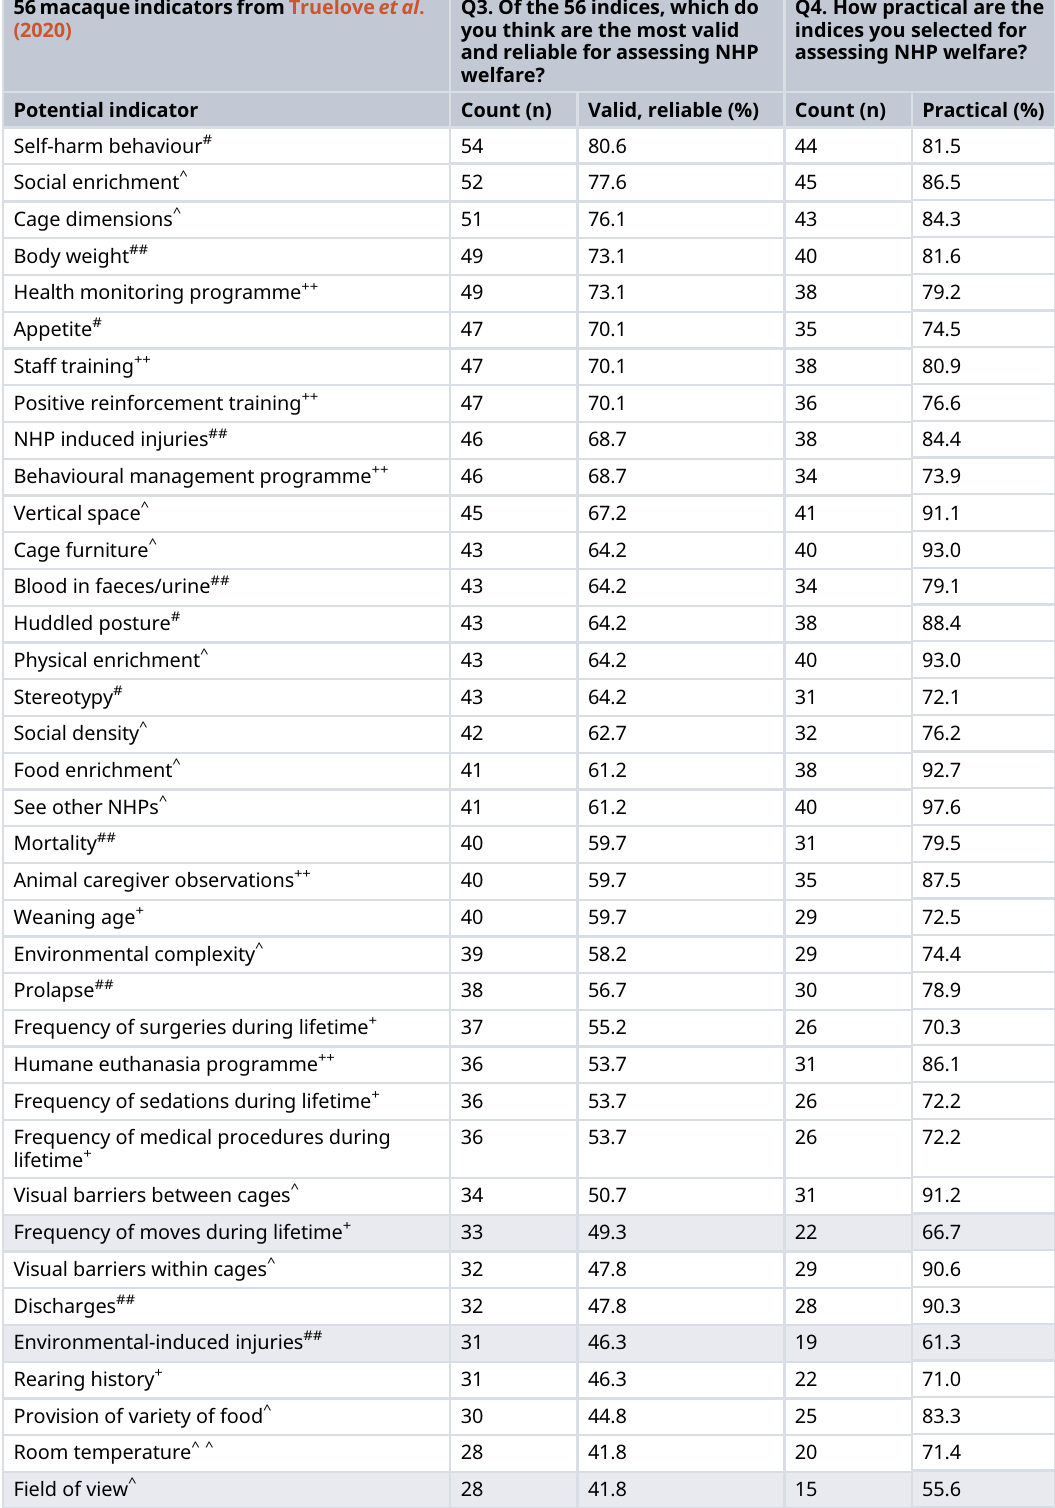
Table 3. Ranking of validity and reliability and practicability scores for macaques, 56 indices (n=67 respondents*). 56macaque indicators from Truelove etal . (2020)